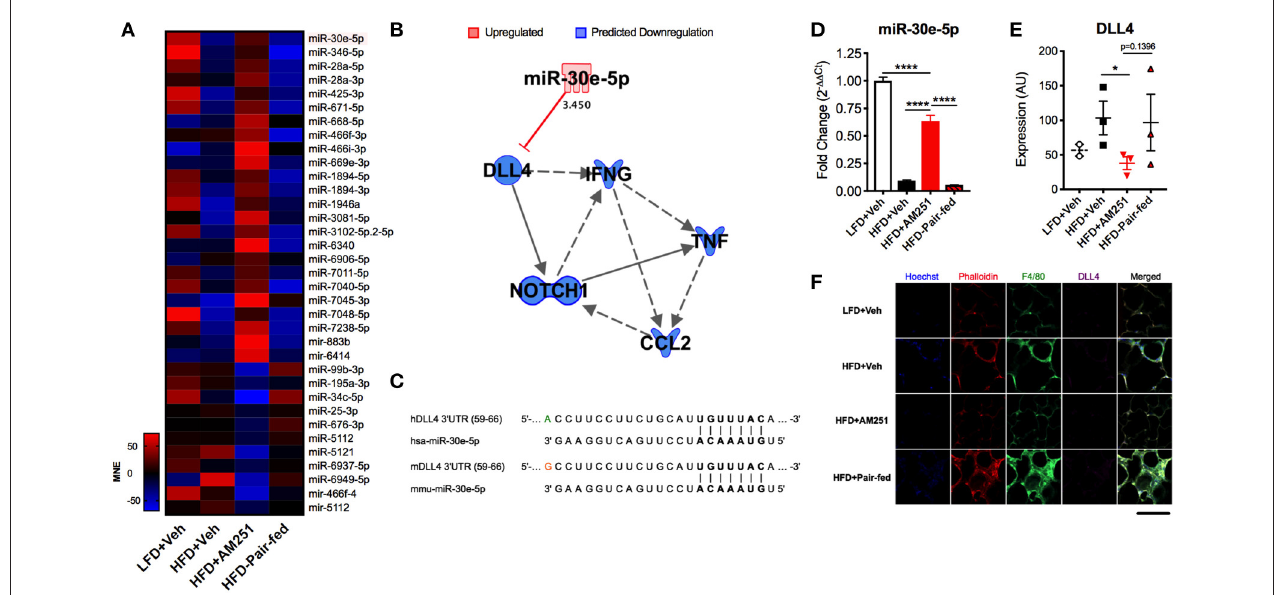
FIGURE 3 | AM251 treatment elevates ATM miR-30e-5p and reduces target expression of the pro-inflammatory Notch ligand Delta-like-4. DIO mice were treated with the CB1 antagonist AM251 (10 mg/kg) as described in Figure 1 legend. MicroRNA microarrays were performed on F4/80 + ATMs isolated from epididymal fat after the 4-week AM251 intervention. (A) Heatmap of differentially expressed miRs in ATMs resulting from AM251 treatment, independent of effects of caloric restriction (Log 2 fold change ≥± 2). (B) Qiagen IPA network of miRs targeting the DLL4-Notch signaling pathway and downstream inflammatory cytokines. Expression values and predictions are overlaid on the network. (C) Sequence conservation of human and mouse miR-30e-5p binding to Dll4 3 ′ UTR. (D) qRT-PCR of miR-30e-5p in ATMs. (E) Confocal microscopy quantitation of DLL4 expression in epididymal adipose tissue. (F) Representative confocal micrographs. Images are to equal scale. For (A,D) , data are presented from independent experiments of 4–10 pooled mice per group. For (E) , N = 3 mice/group. Significance was determined by one-way ANOVA. **** P < 0.0001, * P < 0.05. See also Supplementary Table 1 and Supplementary Figure 1 .